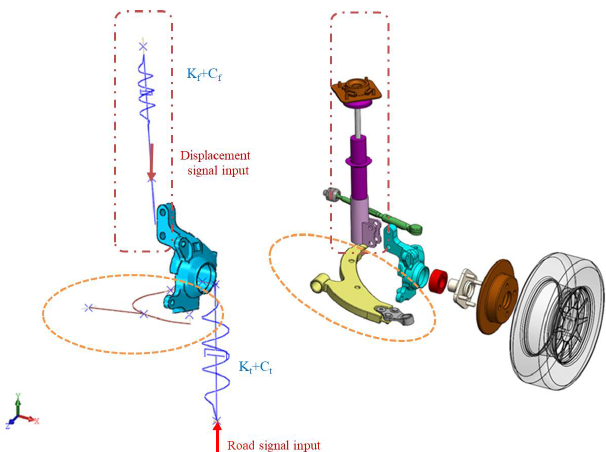
Figure 11. Boundary conditions for fatigue life